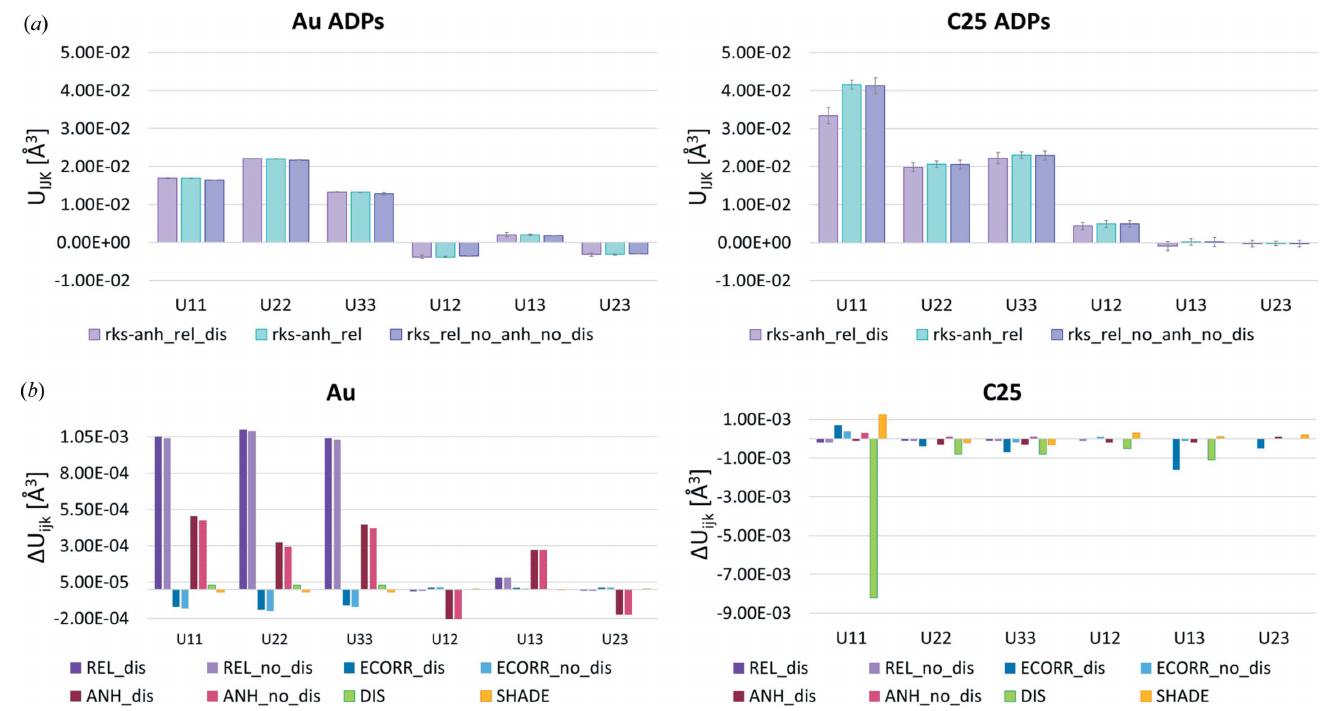
Figure 5 ( a ) Plot of the numerical values of the Au and C25 ADPs (A˚ 2 ) within three e.s.d.’s for models at the rks_rel level of theory with disorder, anharmonicity or no disorder and no anharmonicity; ( b ) effect of REL (rks_anh_rel – rks_anh_nr), ECORR (rks_anh_rel – rhf_anh_rel), ANH (rks_anh_rel – rks_rel) and DIS (rks_anh_rel – rks_anh_rel) in Au and C25 ADPs (A˚ 2 ). For REL, ECORR and ANH the effect of disorder is also